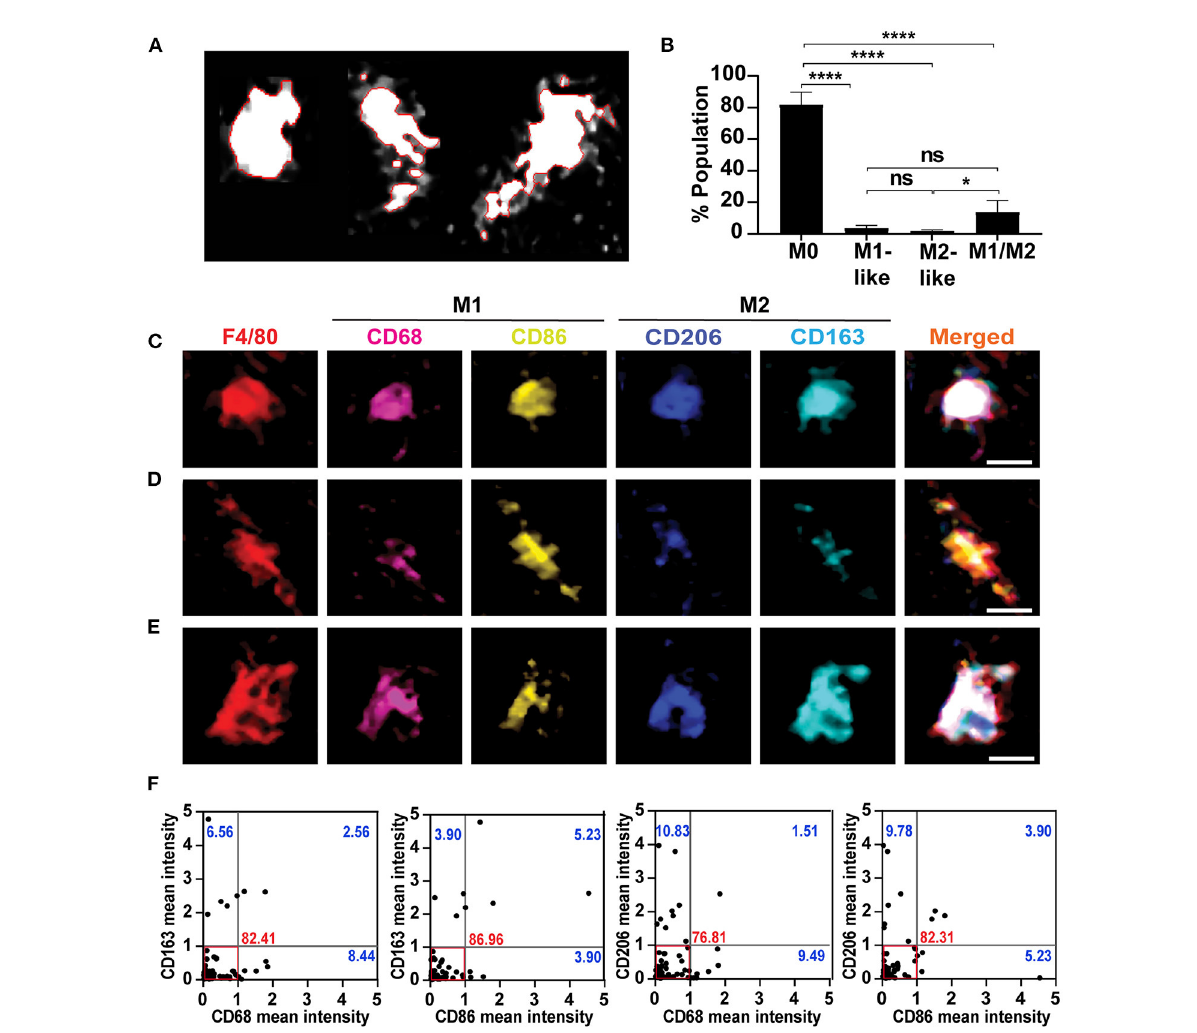
FIGURE2 Classification of mixed macrophages according to the intensity of expressed markers . (A) Watershed cell segmentation to identify the boundaries of single macrophages. Cochlea were obtained from 4-weeks old mice, and immunostained using the mIHC. The red line denotes the boundaries of each macrophage with F4/80 staining. (B) Quantification of the population in the resting state to identify the percentage of each category in the modiolus including auditory nerve and spiral ganglia. Mid-modiolar sections were analyzed, and macrophages population of each category, M0, M1-like, M2-like and M1/M2, were quantified ( n = 5). The M0 non-activated macrophages represented the major percentage among all macrophages, with a significant difference compared to other categories. The mixed M1/M2 macrophages were presented minimally, while the M1-like and M2-like macrophages expressing single marker represented the least percentages. * P < 0.05, **** P < 0.0001, ns: not significant, by one-way ANOVA with Tukey’s multiple comparisons test. The error bars represent standard deviation from the mean. (C) Example of mixed macrophages in which M1 markers (CD68, CD86) expression was similar to that of the M2 markers (CD206, CD163). (D) A representative macrophage of a group of mixed macrophages in which the CD86 (M1 marker) showed the highest expression compared to the other markers. (E) Illustration of another group of mixed macrophages in which CD163 (M2 marker) had the highest expression among all markers. (F) Single-cell-based marker intensity for each mixed macrophage in the modiolus including auditory nerve and spiral ganglia. Each dot represents a single mixed macrophage ( n = 74 from 7 cochleae); the mean intensity of M1 and M2 markers in each macrophage are plotted against each other. The cut-off value was set at 1, below which most of the macrophages were included, and the different types of macrophages were identified. The red box marks the area of the dominant cell population in which most of the macrophages represent M1 and M2 markers equally within the cut-off value. The numbers indicate the percentages of the cell population of each quadrant; in the lower right quadrant, M1-polarized cells expressing higher M1 marker intensities ( > 1) than M2 cells, 8.44, 3.90, 9.49, and 5.23%: the upper left quadrant, M2-polarized cells expressing higher M2 marker intensities ( > 1) than M1 cells, 6.56, 3.90, 10.83, and 9.78%: the upper right quadrant, cells strongly expressing both M1 and M2 markers, 2.56, 5.23, 1.51, and